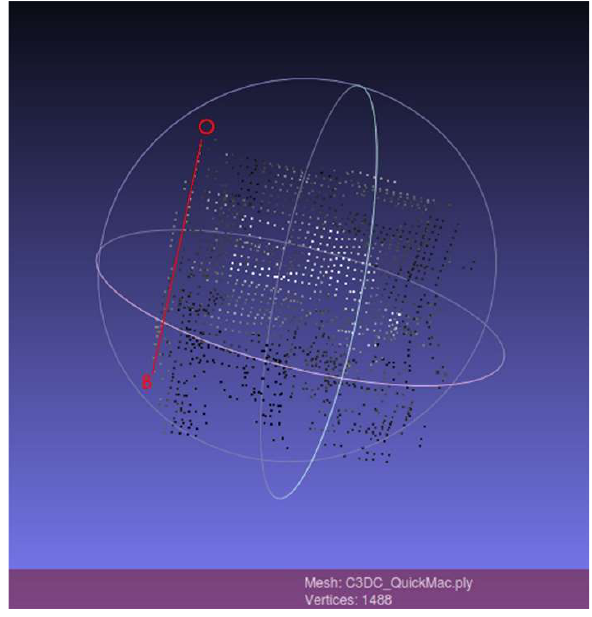
Figure 8. Measures extracted from the old project in plant